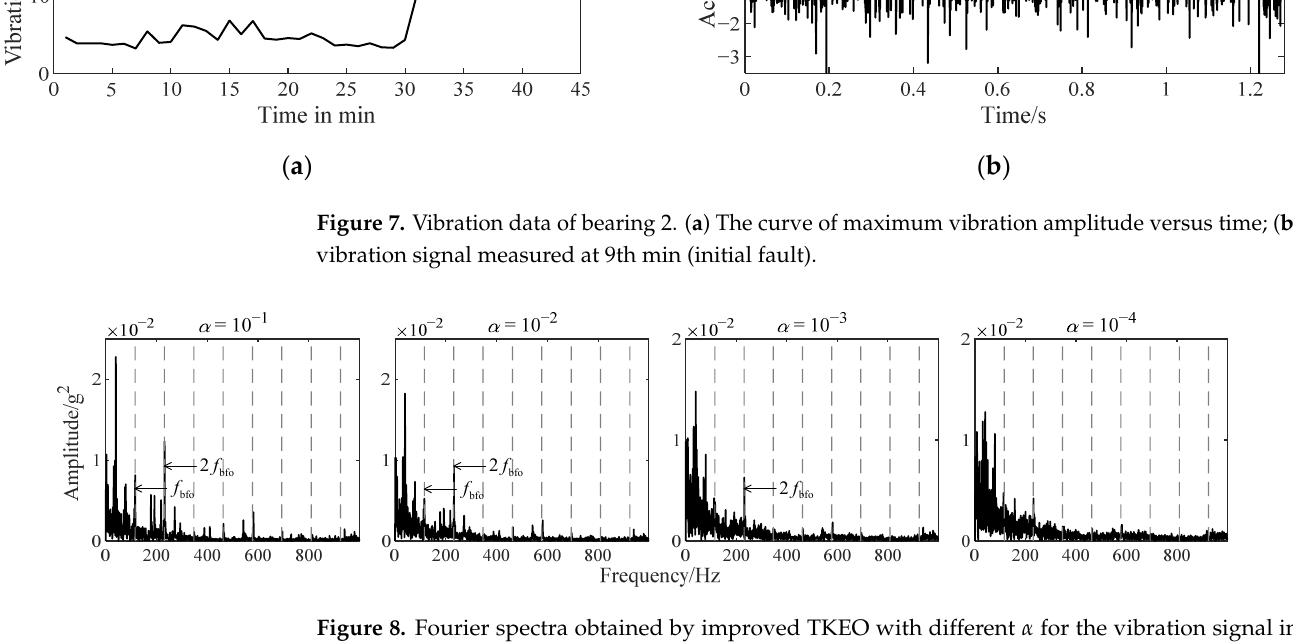
Figure 8. Fourier spectra obtained by improved TKEO with different α for the vibration signal in Figure 7b.